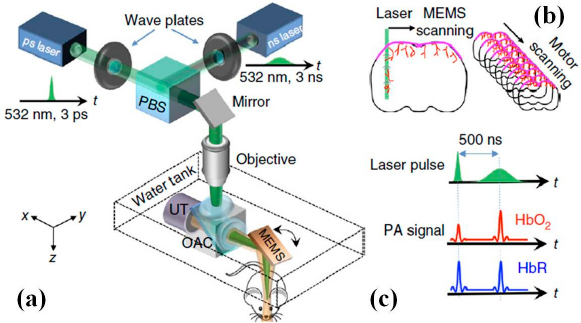
Figure 19. MEMS based fast functional photoacoustic microscopy (PAM) of the mouse brain.